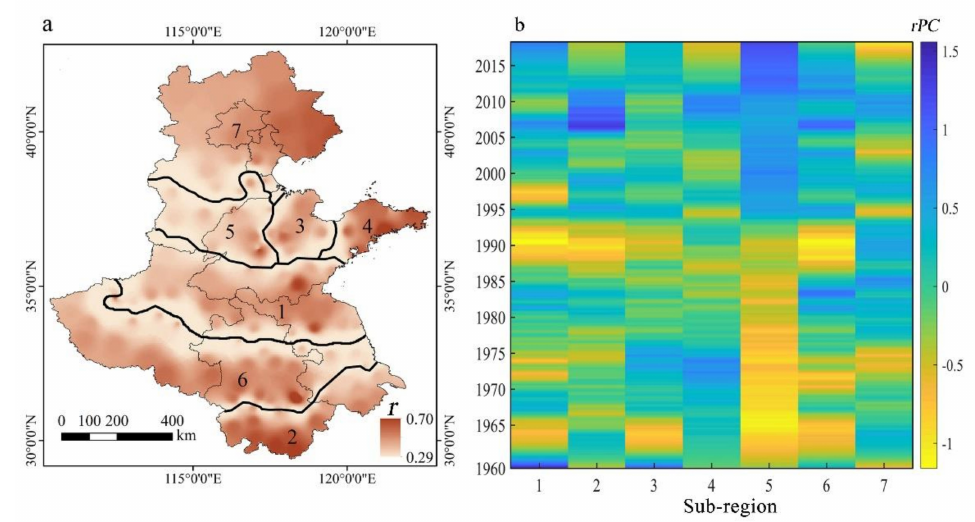
Figure 2. Sub-regions recognized in the North China Plain for spring drought variability ( a ) and the standardized rotated principal component (rPC) time series for sub-regions in spring ( b ). Each sub-region in ( a ) has a number that corresponds to its rPC time series in ( b ), respectively. Sub-region boundaries are thick black lines. The color bar on ( a ) represents the correlation coe ffi cient between the time series of rPC and the original drought data set of each meteorological station (interpolation using inverse distance weighted method). The color bar on the right represents the magnitude and sign of each rPC time series from 1960 to 2017. Negative and positive rPC values indicate dry and wet conditions, respectively. Time series of rPC are 9-year running average